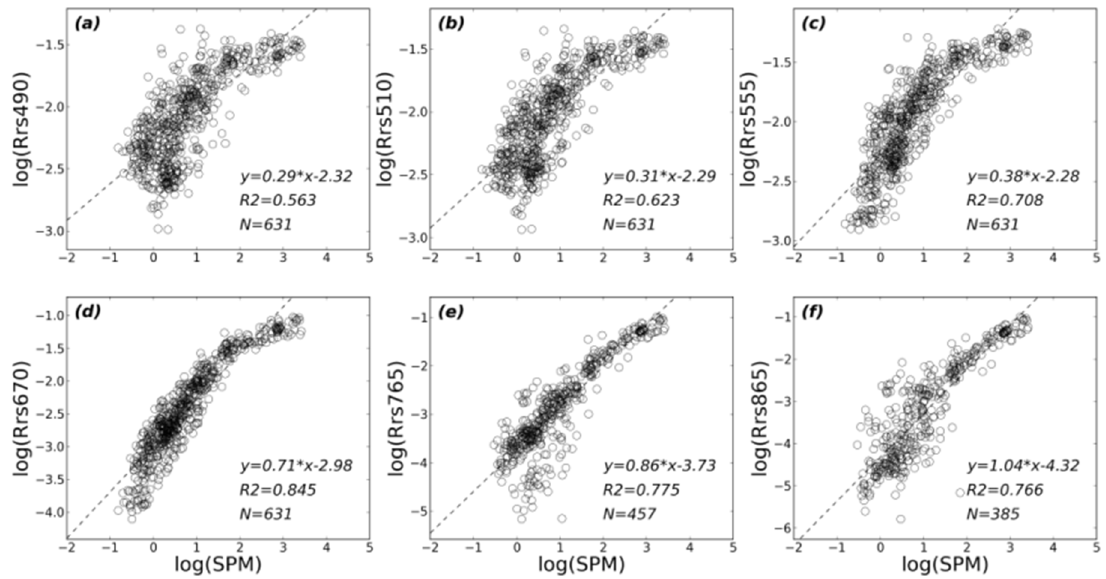
Figure 4. Variation of ( a ) R rs (490); ( b ) R rs (510); ( c ) R rs (555); ( d ) R rs (670); ( e ) R rs (765); and ( f ) R rs (865) as a function of SPM in logarithmic space. The best linear regression fit is also plotted(dashed lines) in each panel.